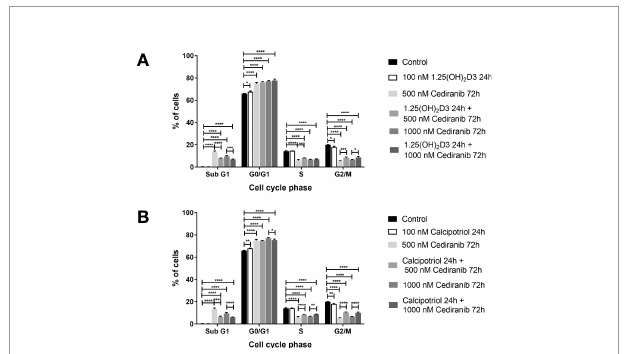
FIGURE 2 | The effect of 24-h preincubation with 1,25(OH) 2 D 3 (A) or calcipotriol (B) at 100 nM concentration on the distribution of human malignant melanoma A375 cells treated for 72 h with cediranib throughout the phases of the cell cycle (SubG1 — apoptotic/necrotic cells, G1 — growth, S — DNA synthesis, G2/M — preparation for mitosis/mitosis). Cells were harvested, stained with propidium iodide, and analyzed by fl ow cytometry. The data are presented as the mean ± standard deviation ( n = 3). The same control and cediranib data are plotted in each graph. Statistical signi fi cance was estimated using two – way ANOVA followed by Tukey ’ s multiple comparison test and presented as * p < 0.05; ** p < 0.01; *** p < 0.001, **** p < 0.0001. The results are representative of four